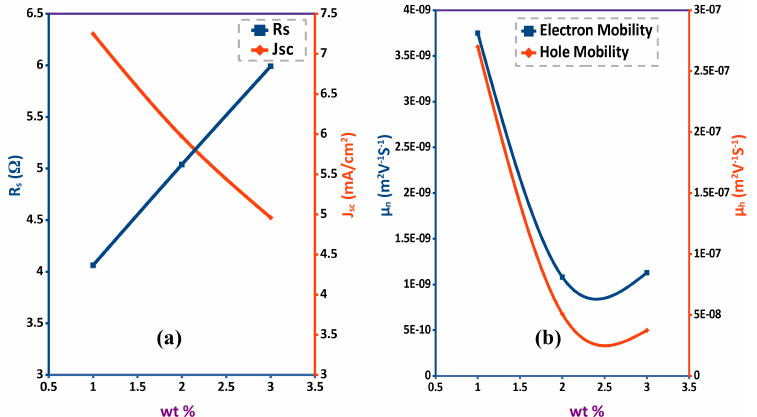
Figure 7. Effect of concentration on: ( a ) series resistance ( R s ) and short circuit current density ( J sc ) ( b ) electron mobility ( µ e ) and hole mobility ( µ h ).